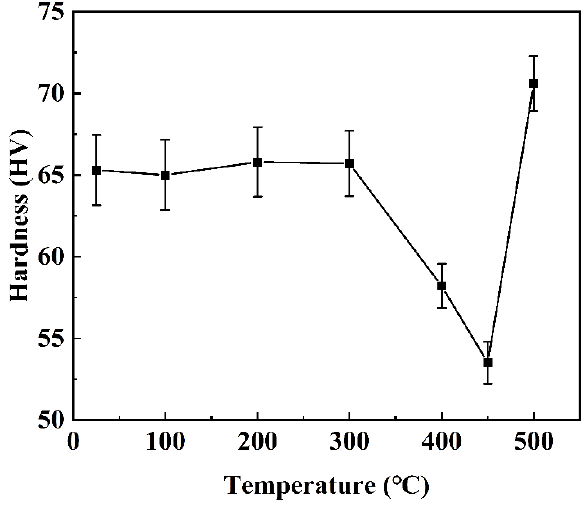
Figure 14. Evolution of sample hardness during homogenization.